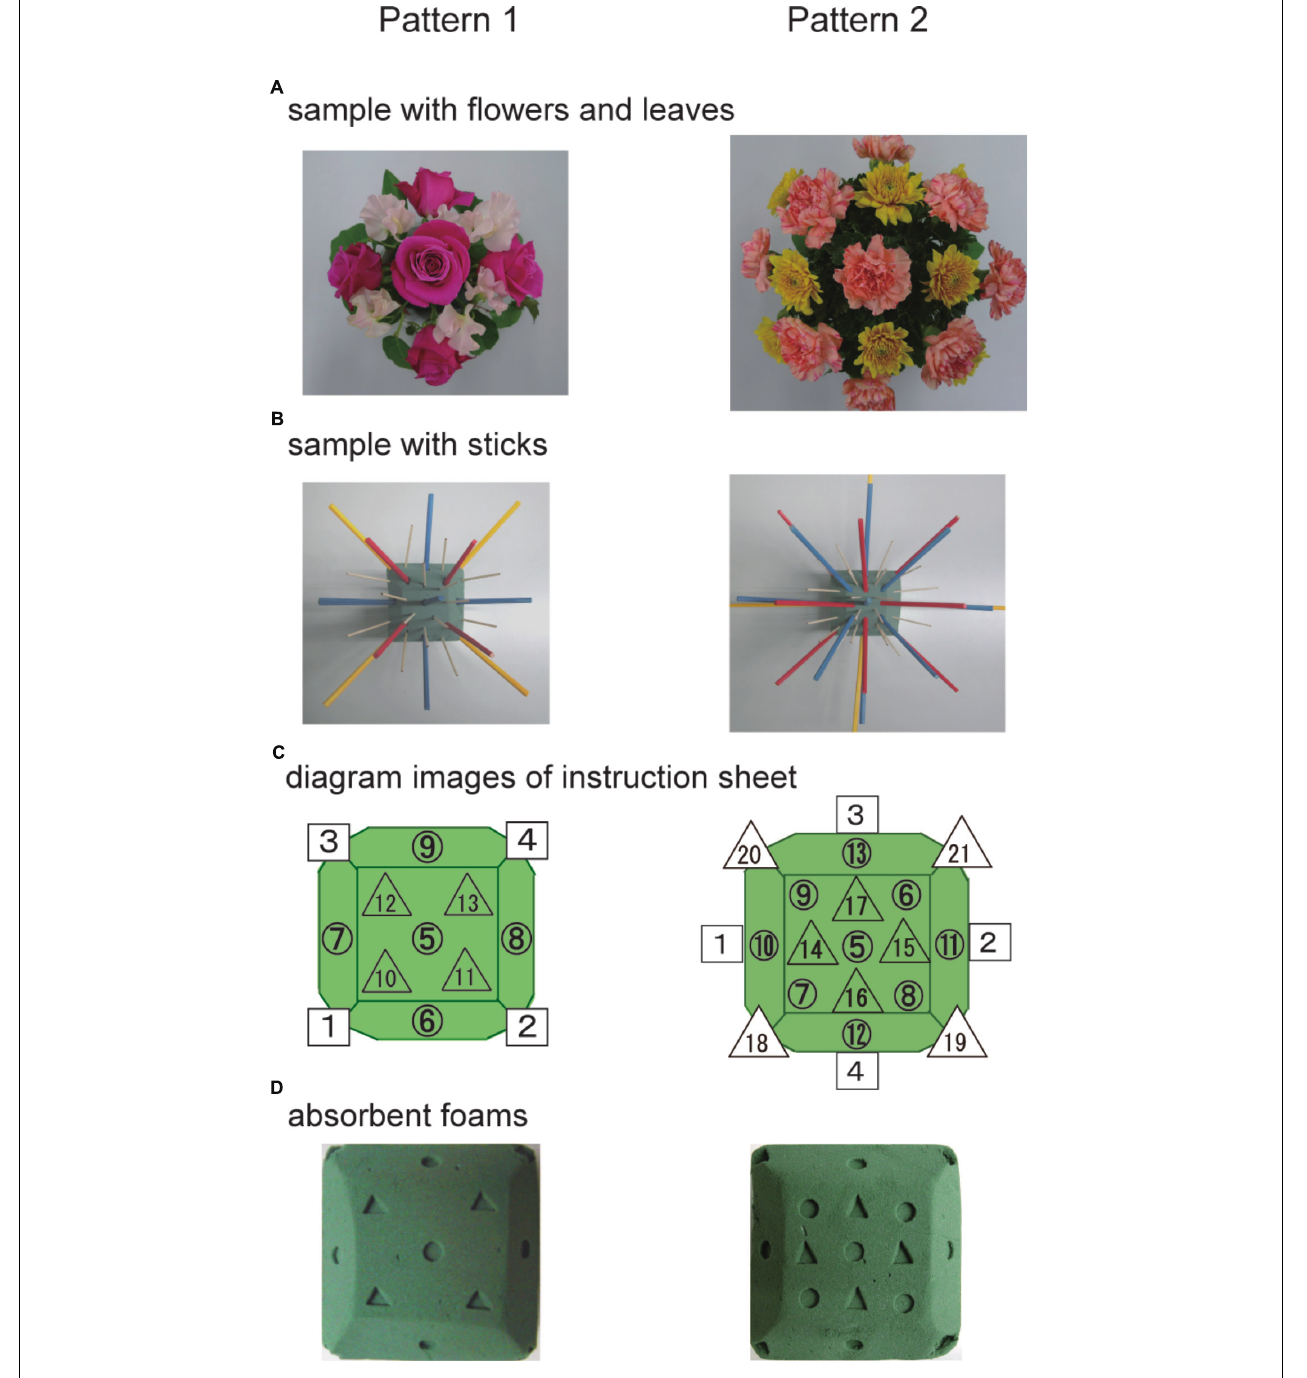
FIGURE 2 | Floral arrangement samples with flowers and leaves (A) and samples with colored sticks (B) . Diagram images of base foam shown in a instruction sheet (C) , and the foams (D) used in the SFA program.